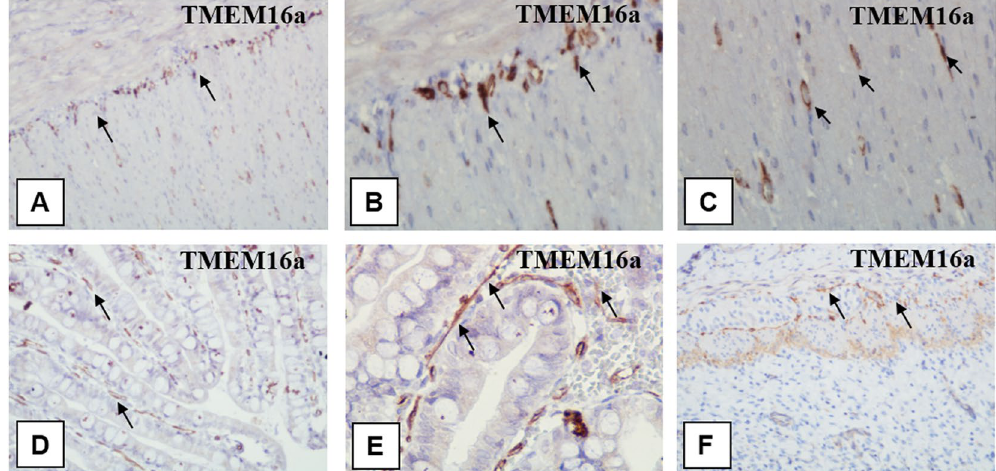
Figure 6. Immunohistochemical staining of the bowel wall with primary antibodies to TMEM 16a ( positive control ). ( А–Е ) The bowel wall (of a five-day-old newborn). Strong telocyte staining is detected in the smooth layer. Telocytes form enclosed structures and capillary walls in the same places. ( A ) х200. ( B ) x400. ( C ) x600. ( D ) and ( Е ) The presence of telocytes in the crypts and different layers (indicated with arrows). ( D ) х200. ( E ) x400. ( F ) The small intestine wall (of a foetus at the 20th week of gestation). Weak immunohistochemical staining of telocytes is detected in the muscle layer,